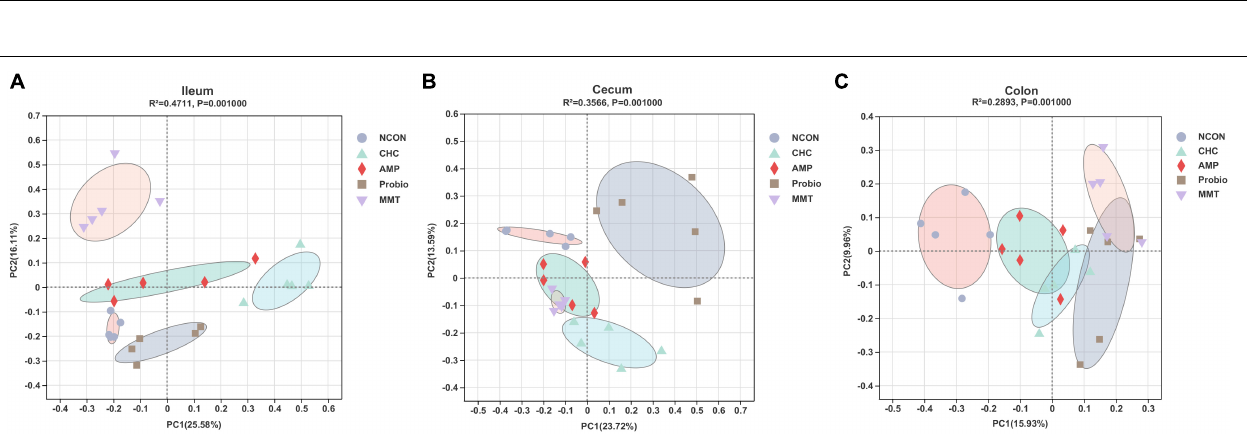
FIGURE 3 | Principal coordinates analysis (PCoA) of bacterial communities in the intestinal digesta of broilers at the ASV level (based on the Bray–Curtis distance). (A) PCoA of ileal microbiota composition. (B) PCoA of cecal microbiota composition. (C) PCoA of colonic microbiota composition. Each symbol represents five intestinal microbiotas in one treatment, and distance between symbols reflects relative dissimilarities in community structures. NCON is a corn-soybean meal basal diets group. AMP is a 200 mg/kg antibacterial peptide supplemented group. Probio is 200 mg/kg calsporin supplemented group. MMT is 500 mg/kg montmorillonite supplemented group. CHC is 500 mg/kg activated charcoal-herb extractum complex supplemented group.